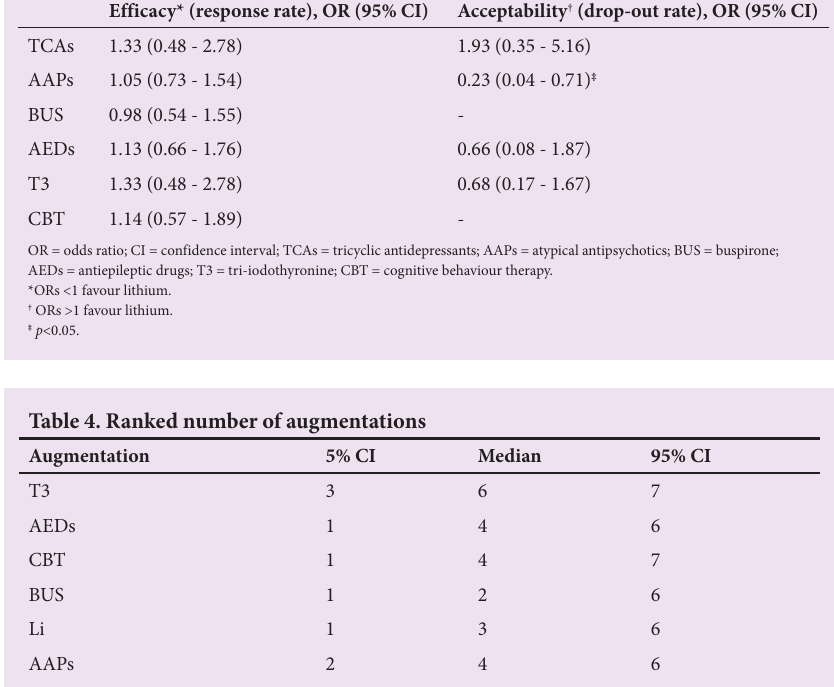
under similar conditions, whether lithium is better than other augmentation agents or not is largely unknown. Research indicated Table 3. Efficacy and acceptability, using lithium as reference compound Efficacy* (response rate), OR (95% CI)